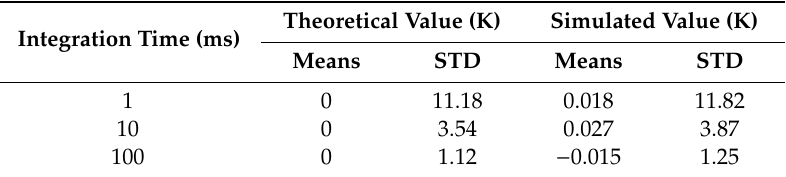
Table 2. Means and standard deviations of radiance difference at different integration times. Theoretical Value Integration Time (ms)